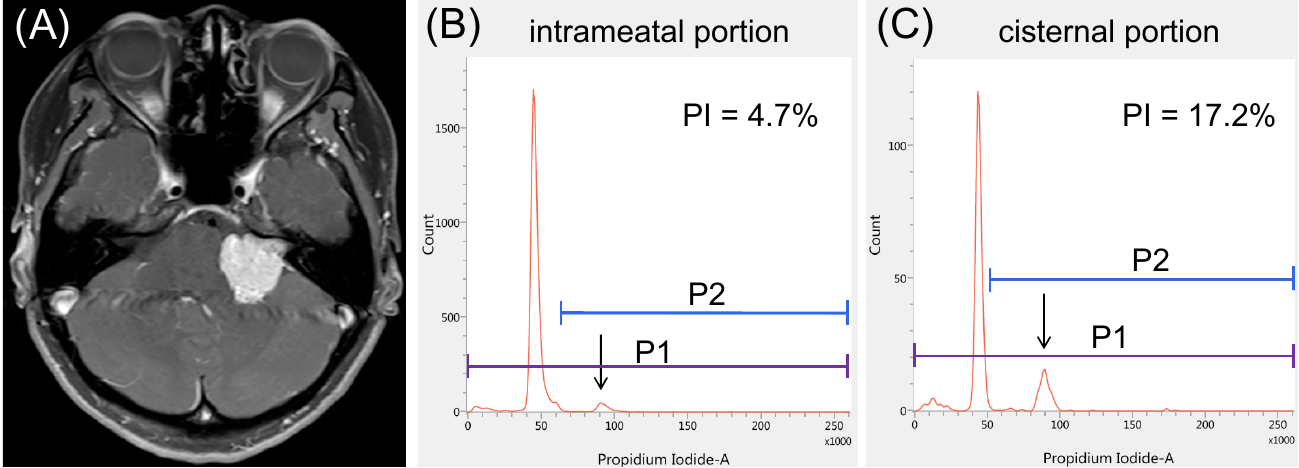
Figure 4. Illustrative case 2. ( A ) A representative case of solid vestibular schwannoma with service- able hearing. The proliferation index (PI) appears to be significantly lower in the ( B ) intrameatal portion than in the ( C ) cisternal portion: 4.7% vs. 17.2%. Arrows represent the peaks of tetraploid cells.